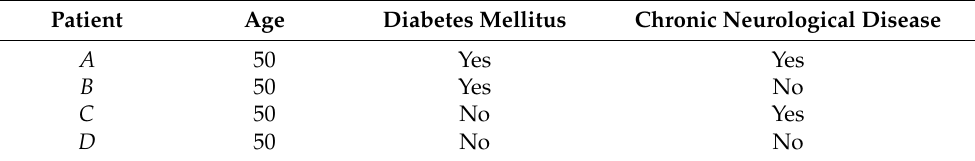
Table 6. Four selected patients.